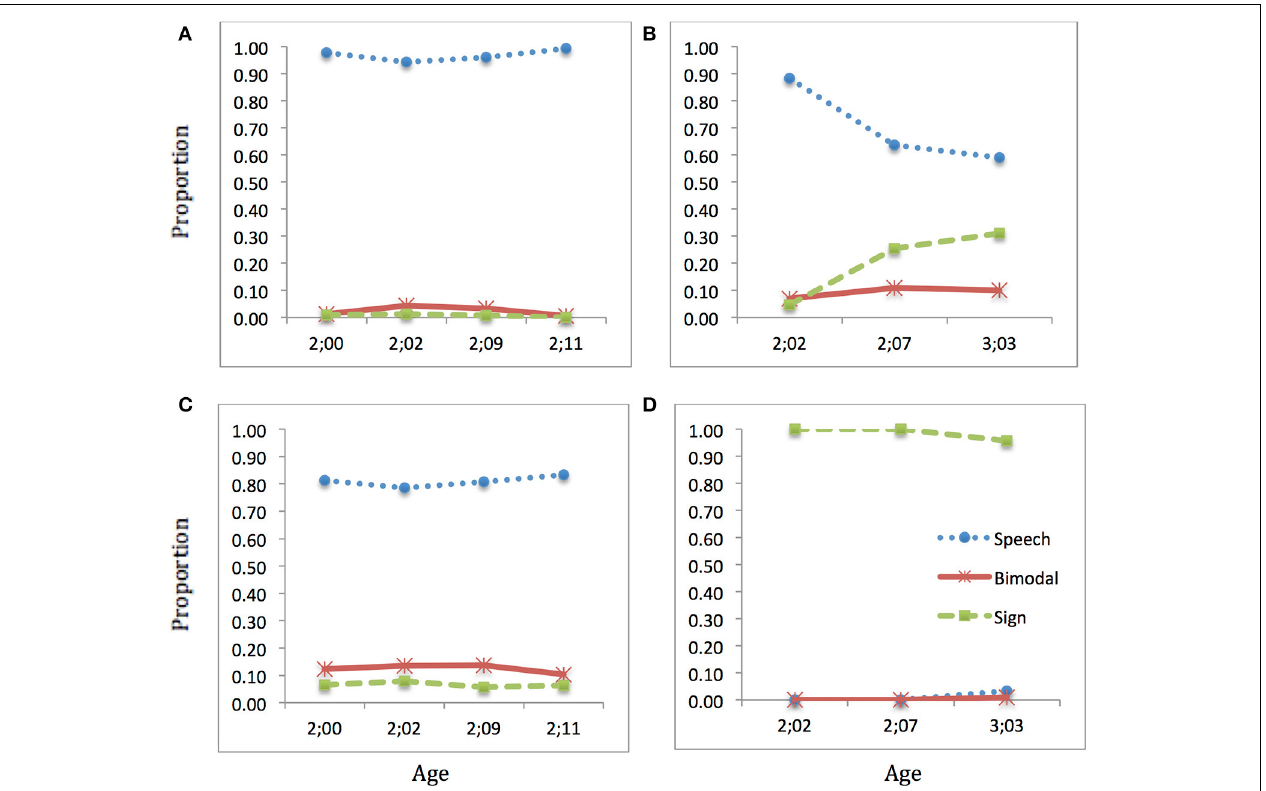
FIGURE 7 | Language choice over time: EDU. Proportion of speech (blue dotted), sign (green dashed), and bimodal (red solid) utterances produced: (A) child speech target; (B) child sign target; (C) interlocutor(s) speech target; (D) interlocutor(s) sign target (Note: Intervals along x-axis are not